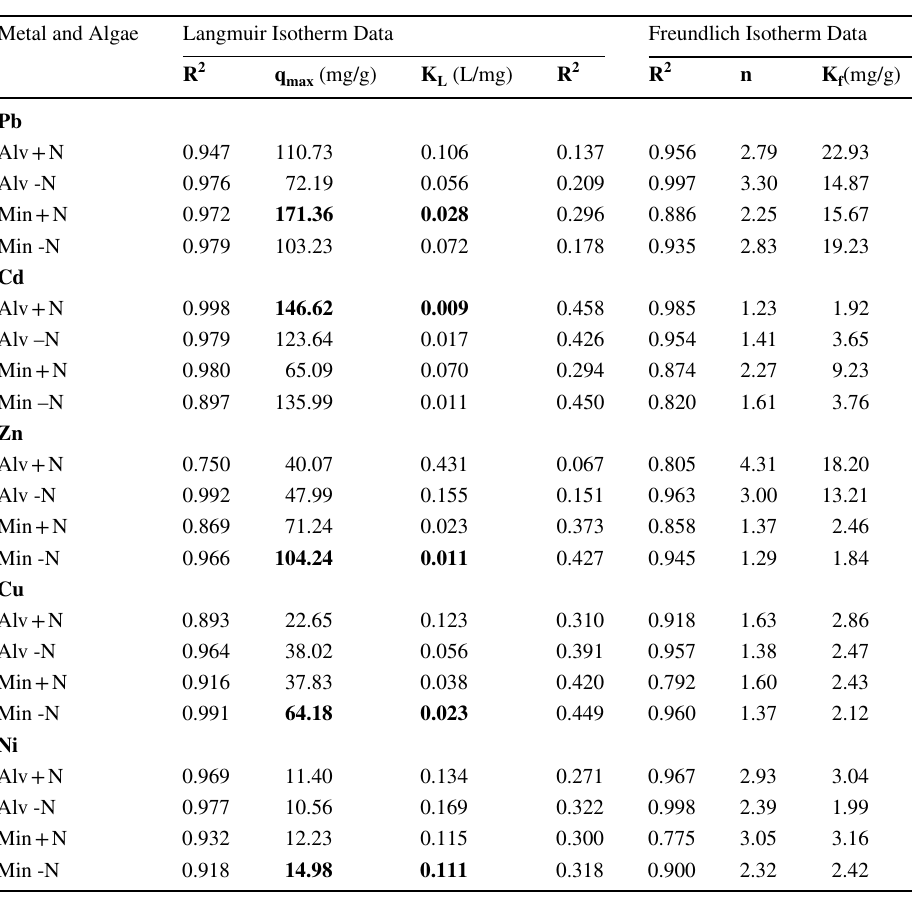
Metal and Algae Langmuir Isotherm